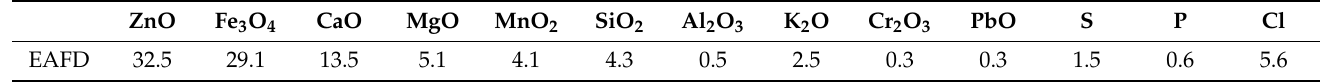
Table 3. Components of EAFD (mass